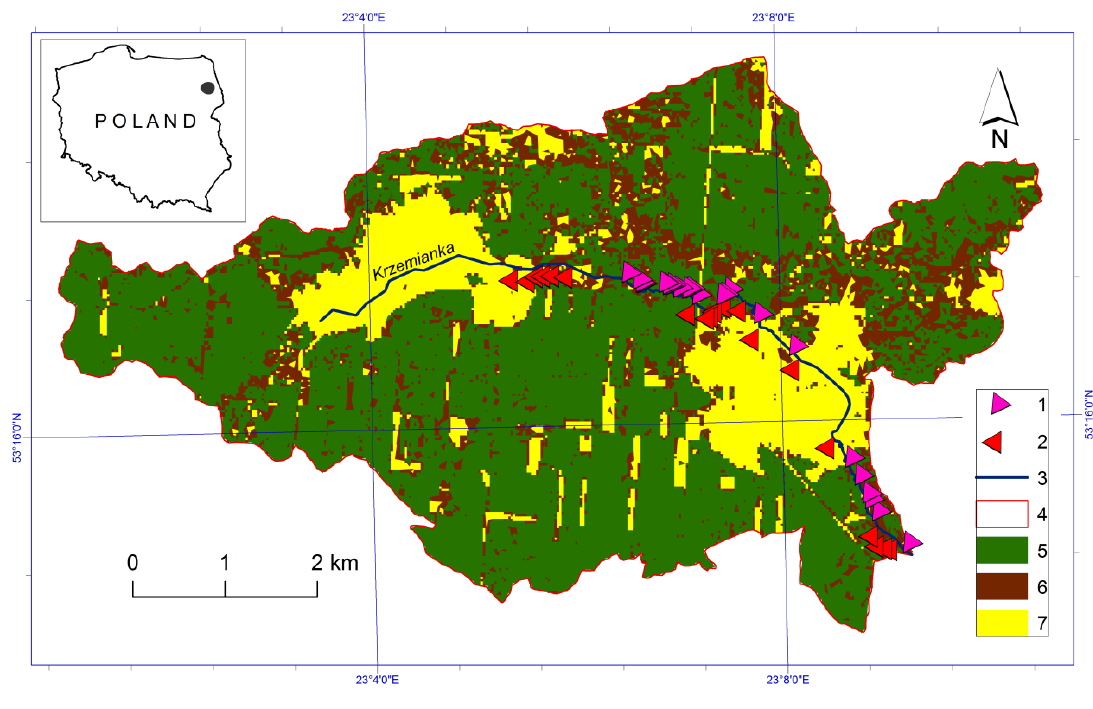
Figure 1. Study area, catchment of Krzemianka River. 1. Location of beaver ponds in 2006; 2. Location of beaver ponds in 2013; 3. River Krzemianka; 4. Boundaries of the catchment; 5. Dry land forests; 6. Riparian forests; 7. Meadows and arable